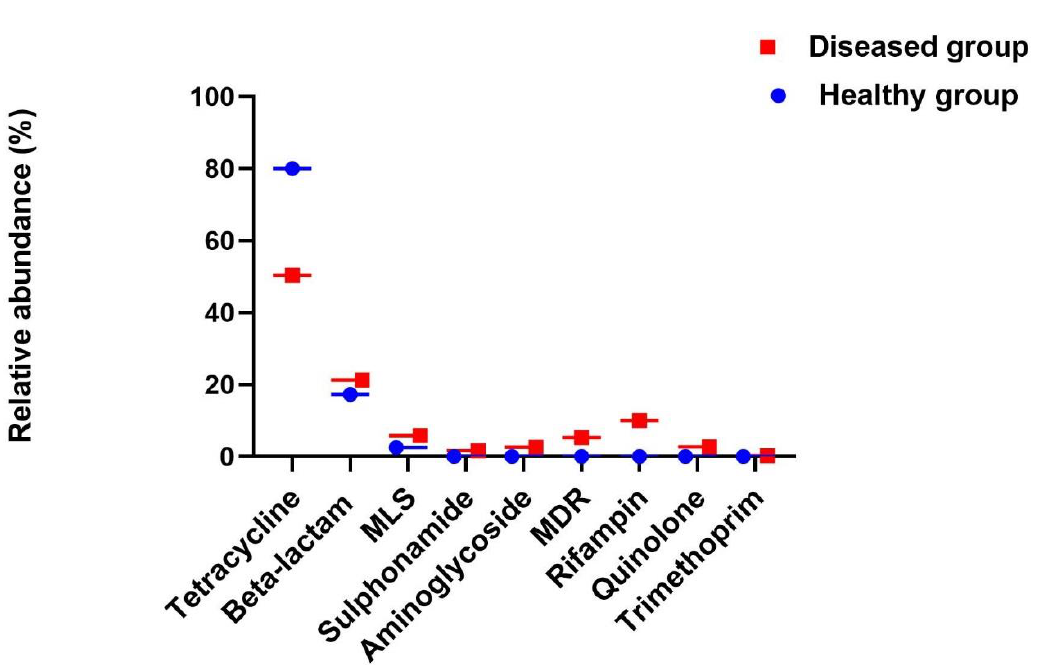
Figure 2. The relative abundance of various antibiotic resistance gene (ARG) types identified in the resistomes of healthy and diseased subjects. The relative abundance of each ARG type was estimated on the basis of total number of reads. MLS—macrolide-lincosamide-streptogramin; MDR—multidrug efflux pump. Table 2. Diversity of various antibiotic resistance genes (ARGs) in the gut resistome of healthy and diseased subjects. ARG